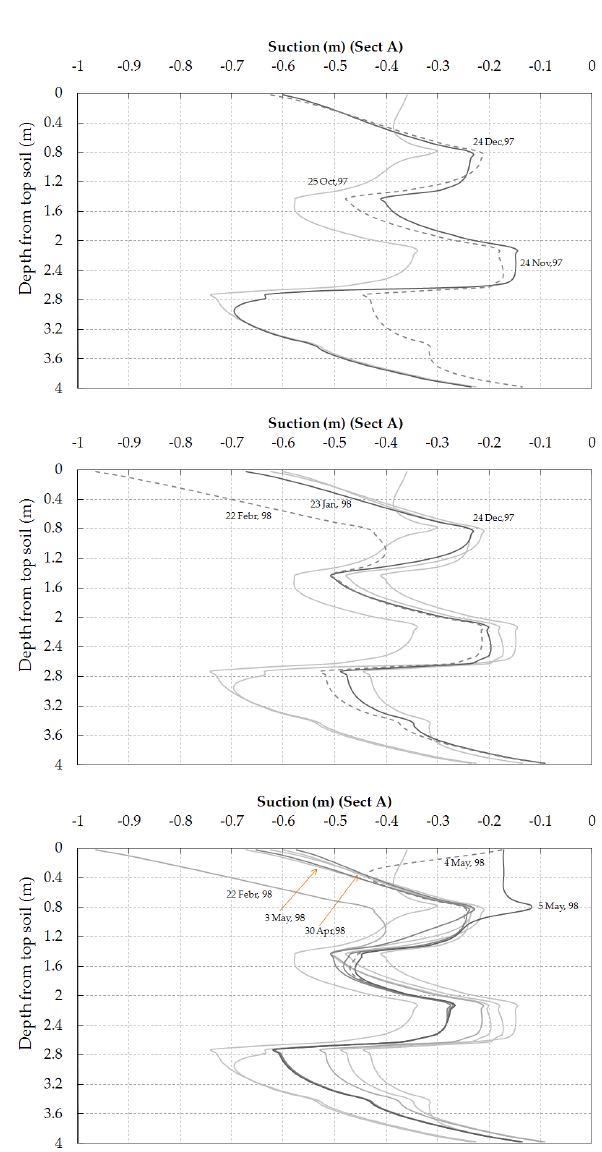
Figure 9. Computed suction profile for the upslope section (Section